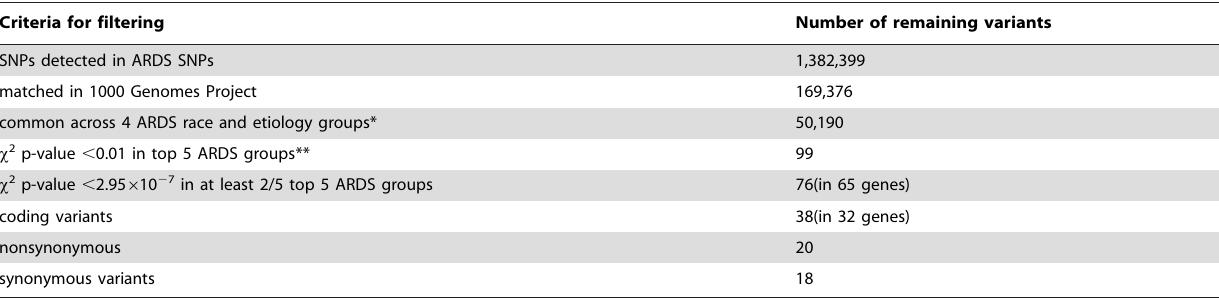
Table 2. Summary of the filtering applied to candidate SNPs.